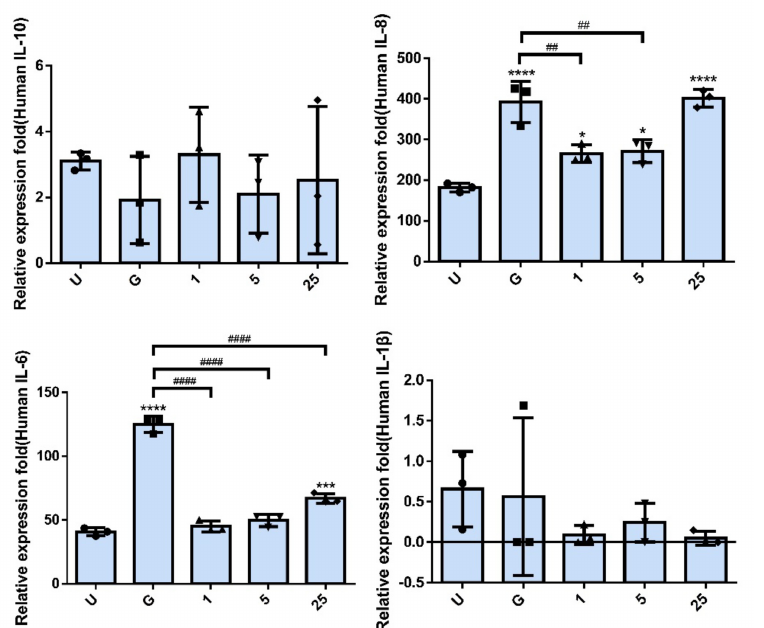
Figure 5. RNase 7 affected the secretion of inflammatory cytokines in UPEC-infected bladder cells. After treatment with different concentrations of RNase 7 (1, 5, and 25 µ g/mL) and 15 mM glucose for 24 h, the release levels of cytokines IL − 8, IL − 10, IL − 1 β , and IL − 6 from UPEC-infected SV-HUC-1 cells were measured using CBA. Cells infected with UPEC alone (MOI:1:100) were used as positive controls. The definitions of each letter/number represented by the X axis are: U: UPEC infection alone; G: with 15 mM glucose pretreatment alone; 1, 5, and 25: pretreated with 1, 5, and 25 µ g/mL RNase 7, respectively, +15 mM glucose. Data are expressed as the mean ± SD of three independent experiments. * p < 0.05, *** p < 0.001, **** p < 0.0001, compared to UPEC infection control groups. ## p < 0.01, #### p < 0.0001, compared between the two